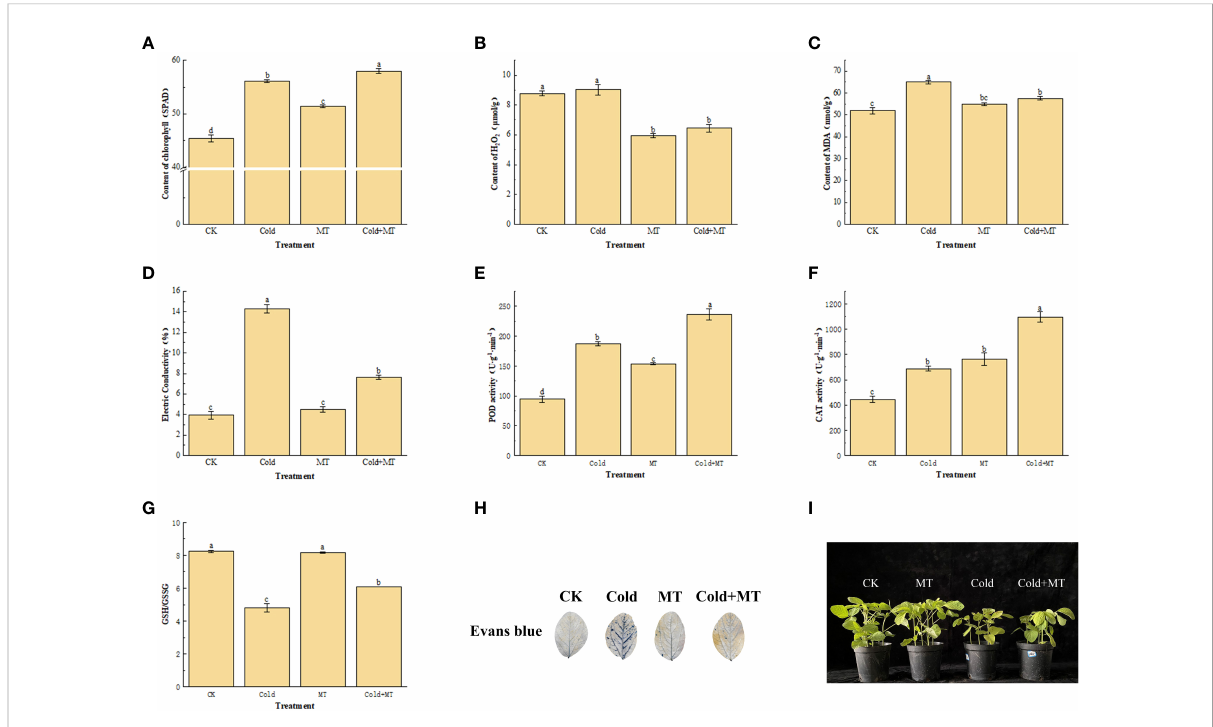
FIGURE 1 Effects of exogenous melatonin treatment on oxidative stress in soybean. (A) Chlorophyll content. (B) H 2 O 2 content. (C) MDA content. (D) Electrical conductivity. (E) POD activity. (F) CAT activity. (G) GSH content. (H) Evans blue staining. (I) Phenotype of soybean seedlings. Note: H 2 O 2 : Hydrogen peroxide, MDA: Malondialdehyde, POD: Peroxidase enzyme, CAT: Catalase, GSH: Glutathione. Error bars represented the standard deviation (SD; n = 3). According to Duncan ’ s multiple tests, bars with different letters were signi fi cantly different (p <